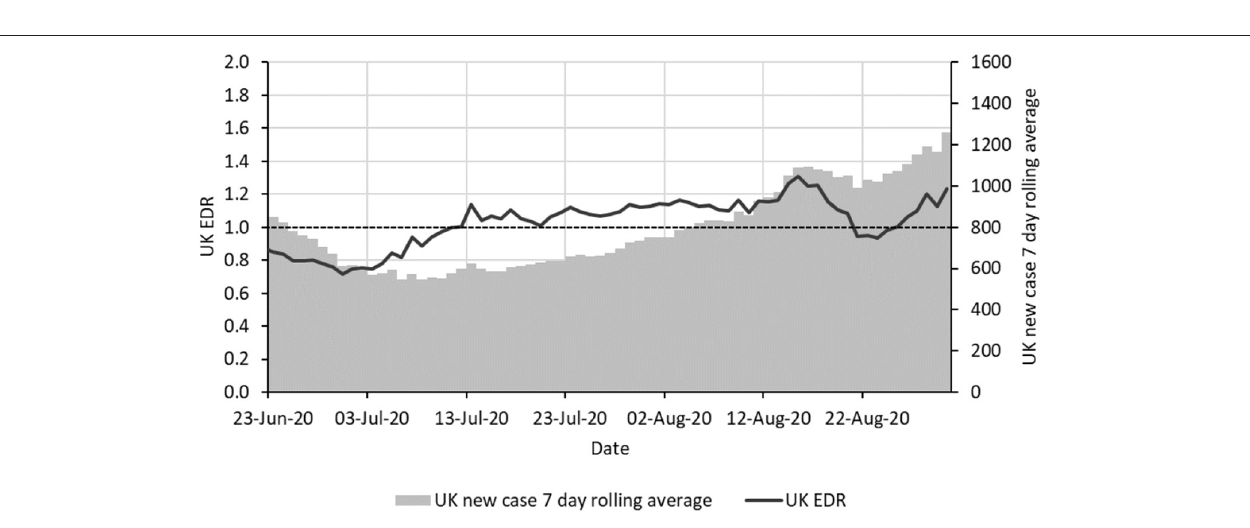
FIGURE 2 | Epidemic curve and EDR for the COVID-19 epidemic in the UK from 23 June to 30 August 2020 with the same format as in Figure 1